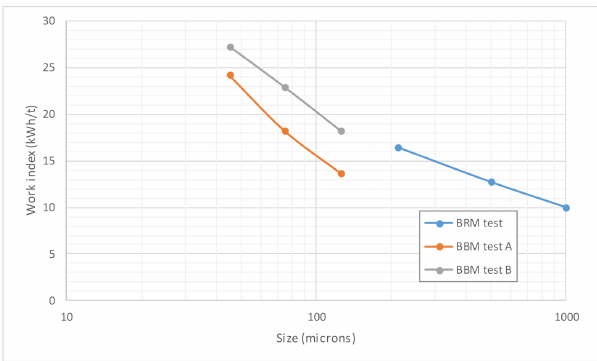
Figure 10. Variation of BBM and BRM w i values with P 100 , Barruecopardo ore.